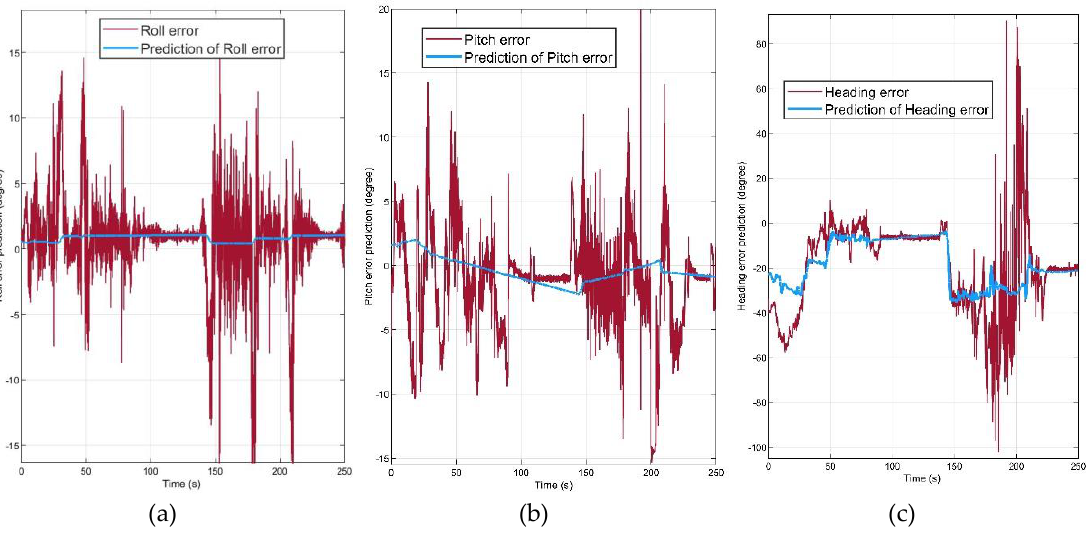
Figure 10. ( a ) Roll error and roll error prediction signal; ( b ) pitch error and pitch error prediction signal; ( c ) heading error and heading error prediction signal.